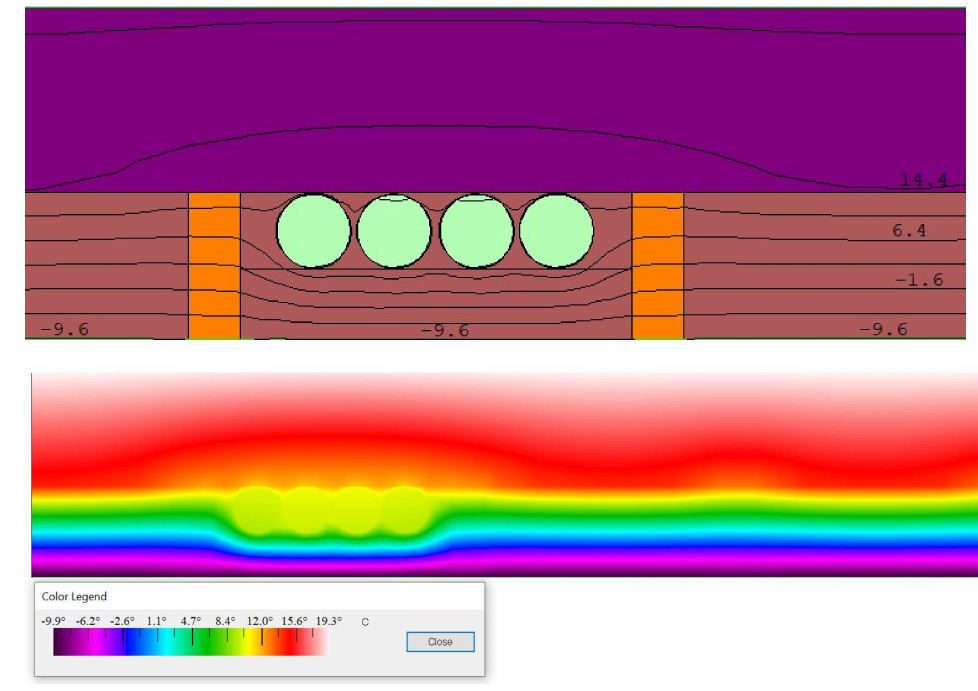
Figure 6. Temperature distribution and heat flow in wooden frame